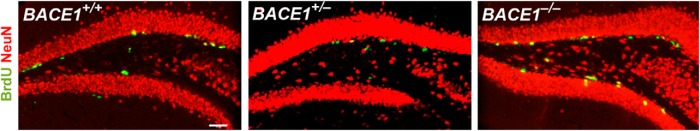
Complete loss of BACE1 activity increases NPC proliferation in the dentate gyrus. BrdU (green) and NeuN (red) coimmunofluoresence in the dentate gyrus of BACE1+/+, BACE1+/–, and BACE1–/– mice 1 d after BrdU injection. BACE1–/– mice exhibit significantly more BrdU+ cells compared to BACE1+/+ or BACE1+/– mice. Scale bar: 50 µm (adapted from Fig. 2A in Chatila et al., 2018).